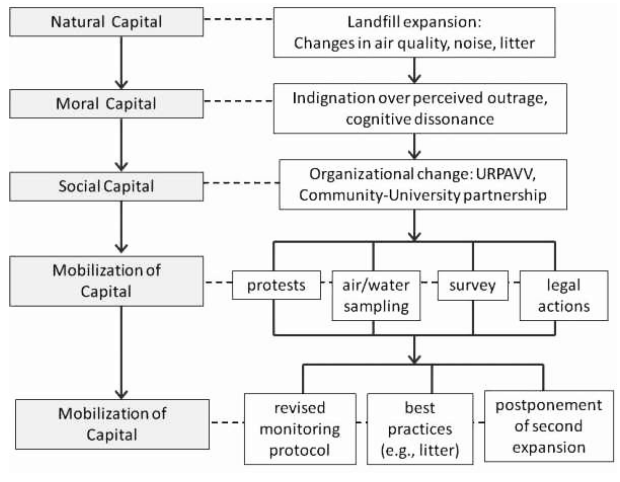
Fig. 2 . Cross-dimensional